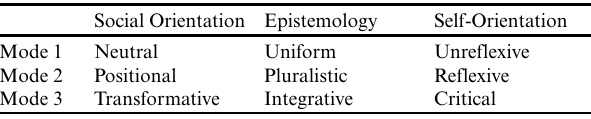
Table 2 . Comparison of research in Modes 1, 2, and